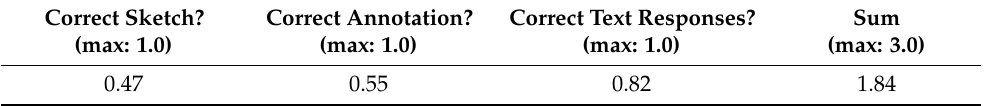
Table 1. Assignment Assessment